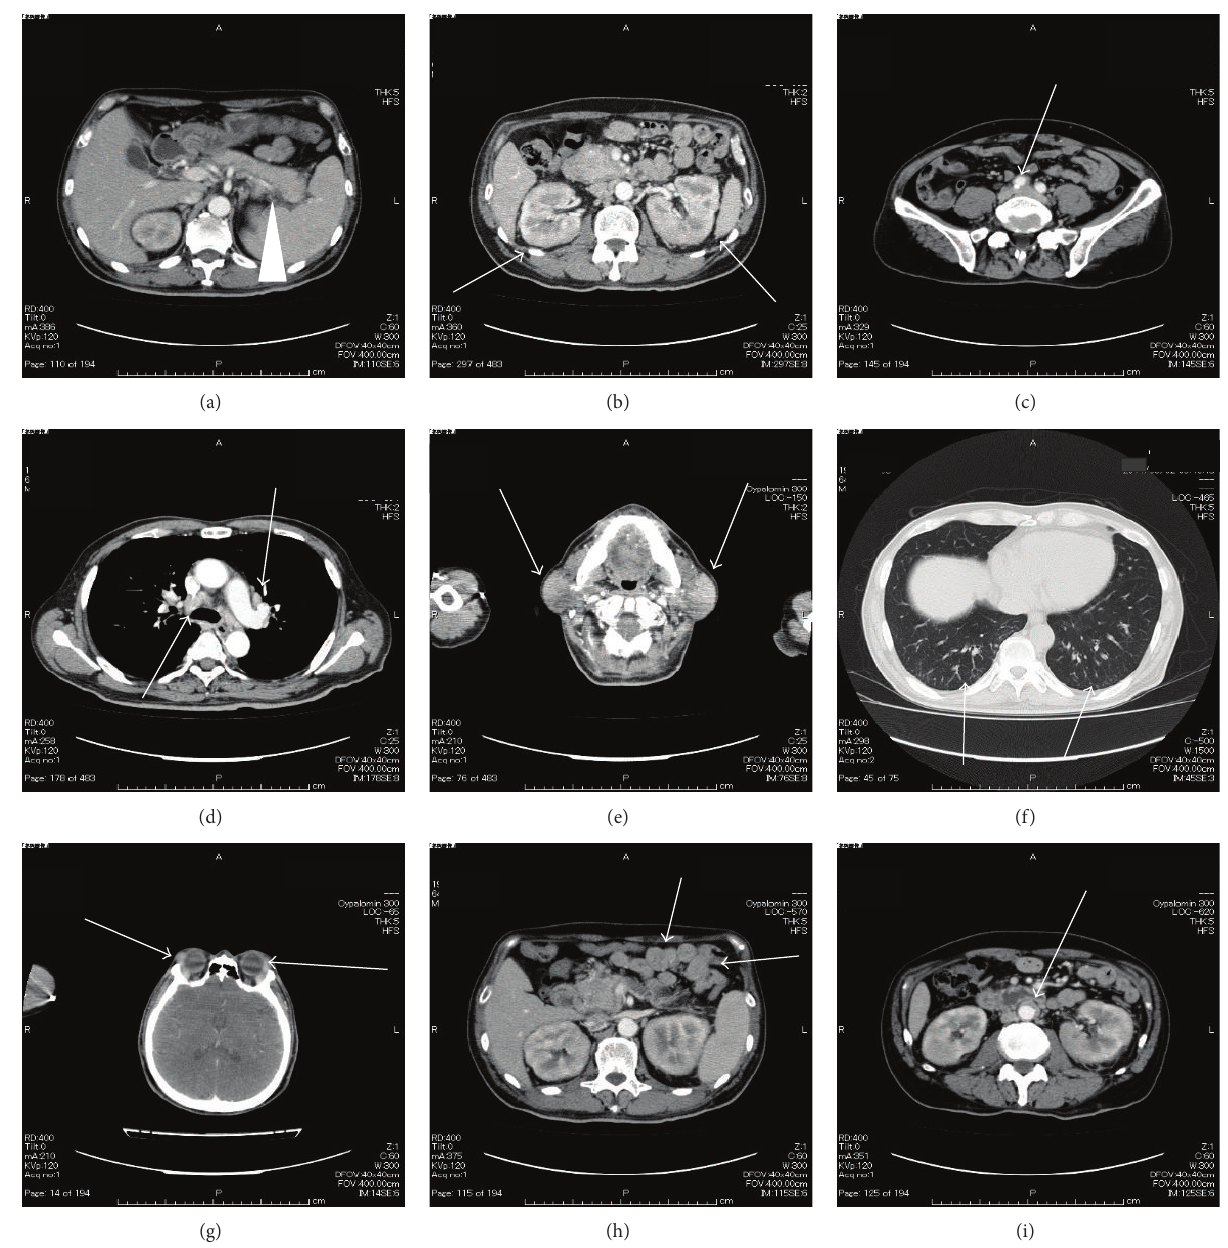
Figure 2: Contrast-enhanced computed tomography. It showed diffuse enlargement of the pancreas which involved something like a capsule that did not show enhancement in the early stage and showed enhancement in the late stage around the rim of the body and caudal portion ((a), white arrow), splenomegaly ((a), white arrowhead), multiple, small, low-attenuation lesions with swelling in bilateral kidneys ((b), white arrows), soft tissue shadow around the right common iliac artery ((c), white arrow), swelling of mediastinal and pulmonary hilar lymph nodes ((d), white arrows), swelling of bilateral submandibular parotid glands ((e), white arrows), centrilobular shadows in both lower lobes ((f), white arrows), swelling of the lacrimal glands ((g), white arrows), edematous changes of jejunum ((h), white arrows), and soft tissue around the abdominal aorta ((i), white